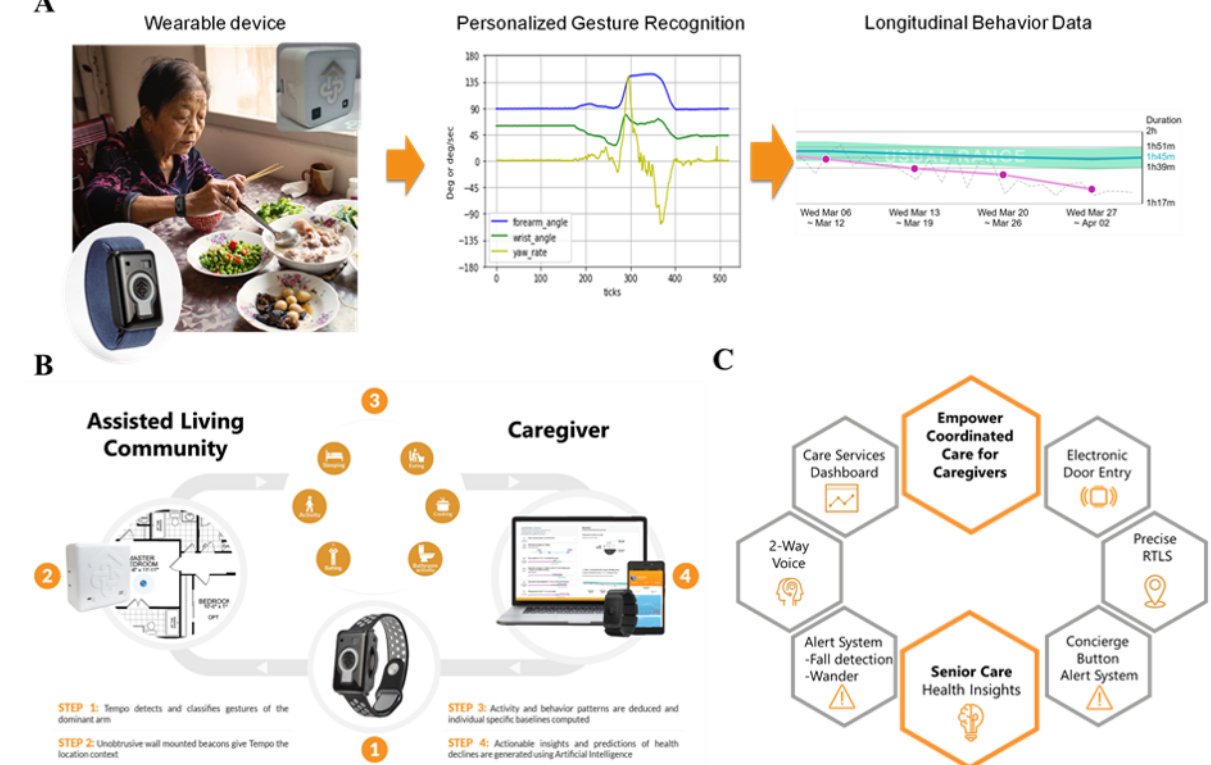
Figure 2. AI-powered digital health platform, wearable device, and room location system. A. Wearable device and sample representation of